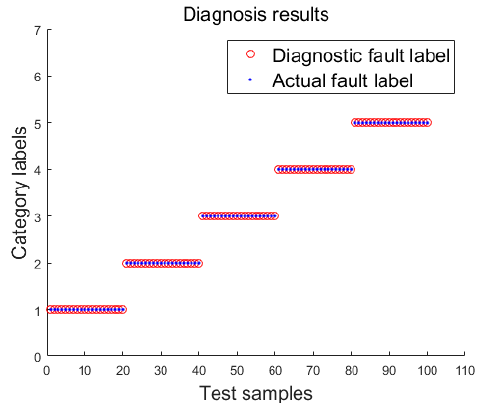
Figure 22. Classification result under condition 1.